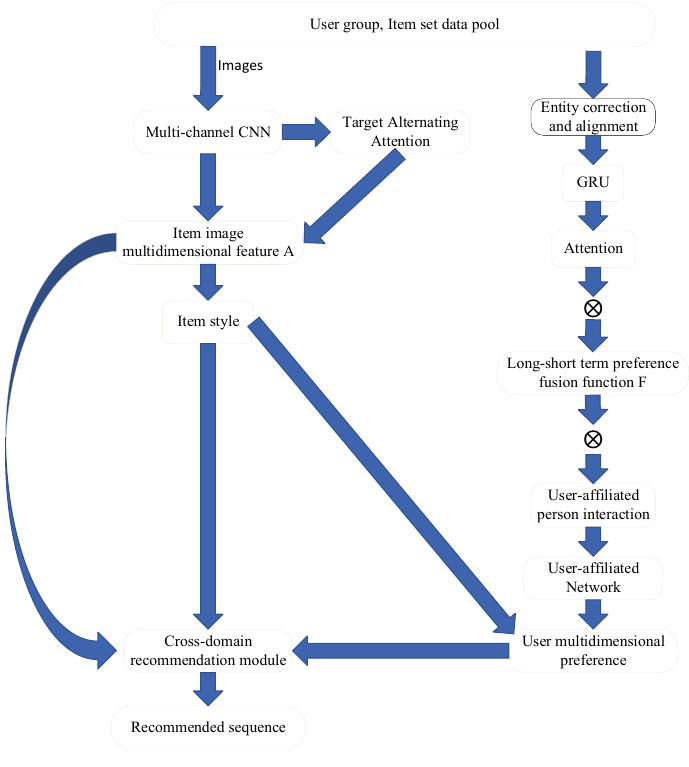
Figure 2. Flow chart of